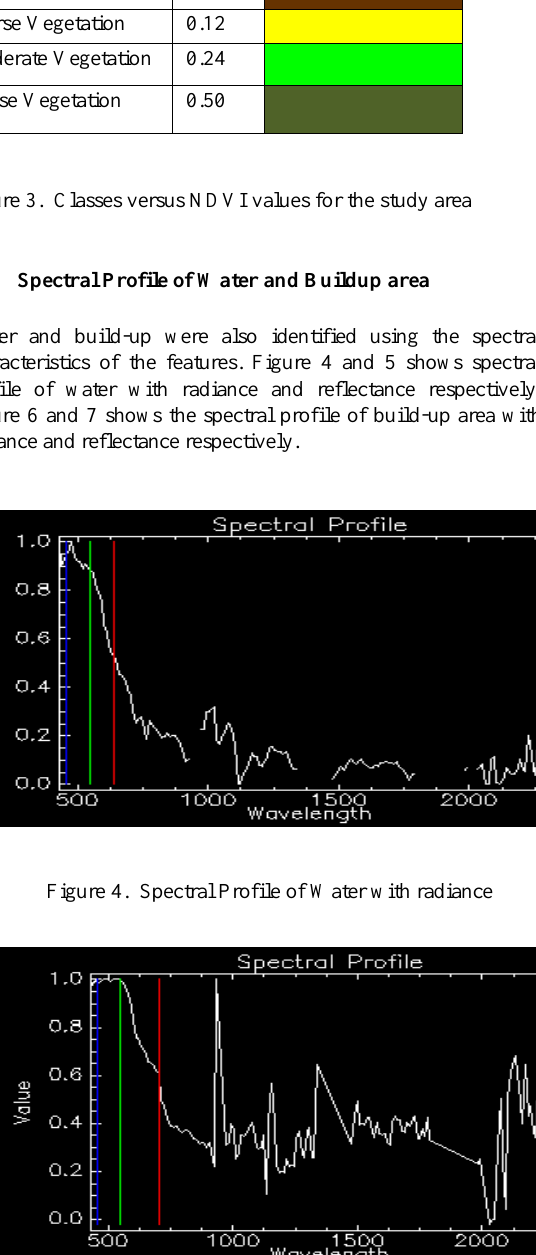
Figure 5. Spectral Profile of Water With